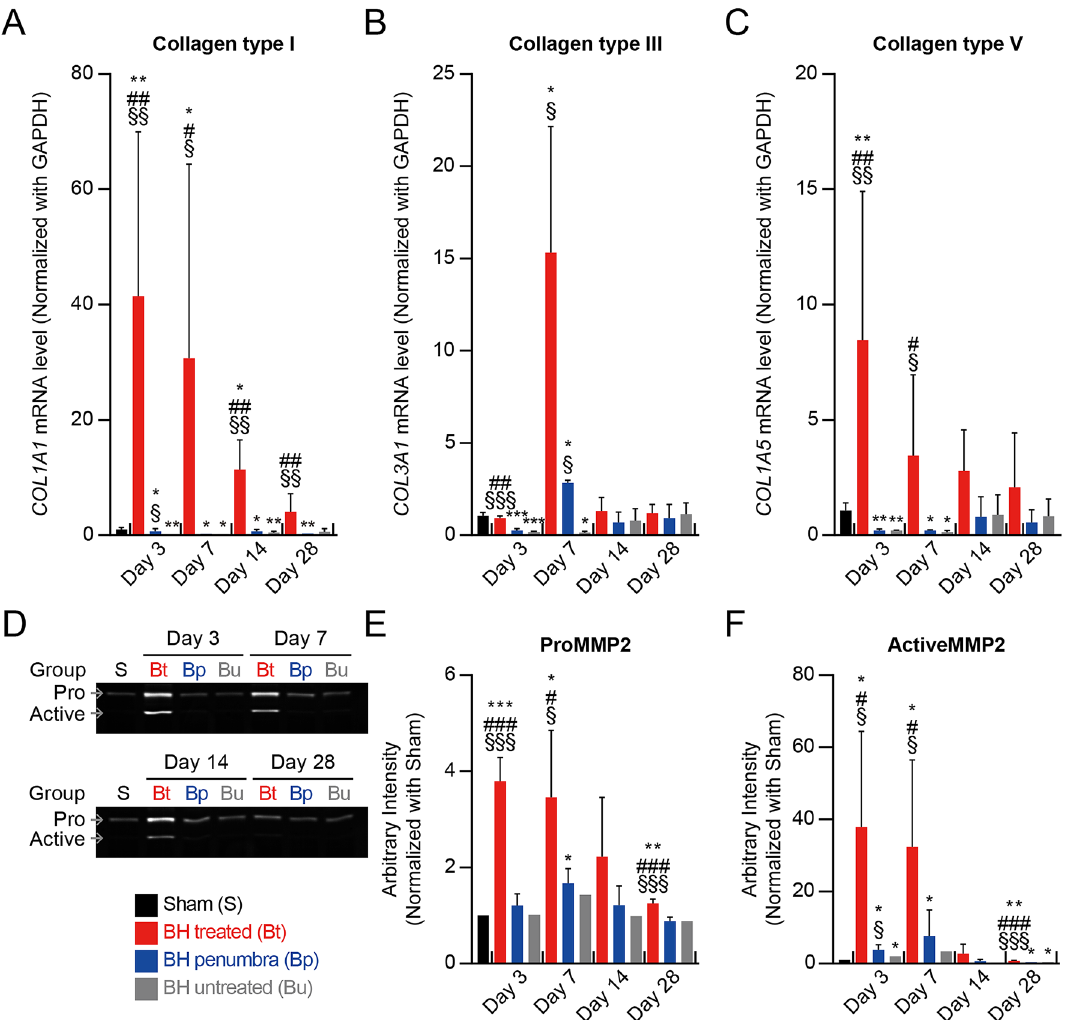
Figure 3. Degradation of fibrillary collagens by active MMP-2. ( A – C ) Expression mRNA levels of collagen type I, III and V. n = 5 for Sham, n = 3 for Day 3 and 7, n = 4 for Day 14, and n = 5 for Day 28. ( D ) Representative image of MMP-2 gelatin acrylamide gel zymography. ( E and F ) Quantitative analysis of the relative levels of MMP-2 activity in liver lysates. n = 2 for Sham, n = 3 for Day 3, n = 4 for Day 7 and 14, and n = 5 for Day 28. Data are presented as means ± SD. One-way ANOVA followed by post-hoc Tukey’s test was used. § p < 0.05 vs. BH untreated of each time point, §§ p < 0.01 vs. BH untreated of each time point, §§§ p < 0.001 vs. BH untreated of each time point, # p < 0.05 vs. BH penumbra of each time point, ## p < 0.01 vs. BH penumbra of each time point, ### p < 0.001 vs. BH penumbra of each time , *p < 0.05 vs. sham , **p < 0.01 vs. sham and ***p < 0.001 vs. sham (Fig. 2E-ii and F-ii). From Masson’s trichrome staining results shown in Fig. 2F, a denser collagen matrix with fibroblasts occurred at the boundary of the BH lesion (Fig. 2F-i). On day 14, regenerated hepatocytes and newly formed blood vessels within the BH lesion were found as shown in Fig. 2G-i and H-ii. Some collagen matrix still remained around the portal veins (Fig. 2H and H-i). Along with a significant reduction of collagen matrix, regenerated hepatocytes, portal veins, central veins and portal area were clearly observed within the BH-treated region on day 28 (Fig. 2I and J). Degradation of fibrillar collagens by matrix metalloproteinase‑2 (MMP‑2) activation. MMP-2 (gelatinase A) is a key representative inhibitor of collagen. Excessive collagen formation after injury is regulated by MMP-2 activation which breaks down the collagens 33 . In the present study, qPCR assay for measurement of collagen expression (collagen type I, III and V) and gelatin zymography for detection of MMP-2 activation were performed on the BH-treated, BH-penumbra and BH-untreated regions (Fig. 3 and Supplementary Fig. S1). On day 3, the mRNA expression level of collagen type I (the most abundant protein among the fibrillar collagens of ECM) at the BH-treated region was 41-fold higher than that of the sham group, as shown in Fig. 3A. Along with this, significant elevations of pro and active MMP-2 levels were also observed (i.e., 3.8-fold change in proMMP-2 and 38-fold change in activeMMP-2) (Fig. 3D–F). These were then reduced on day 7 and reached a base level on day 28. These findings indicate the breakdown of the ECM structure under activation of MMP-2. Similarly,